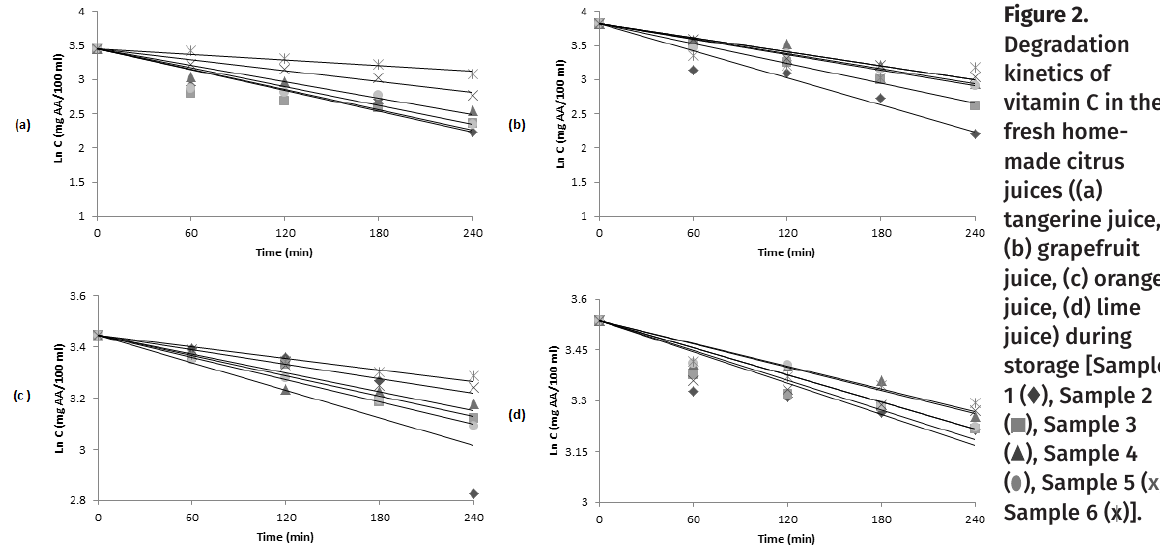
Degradation kinetics